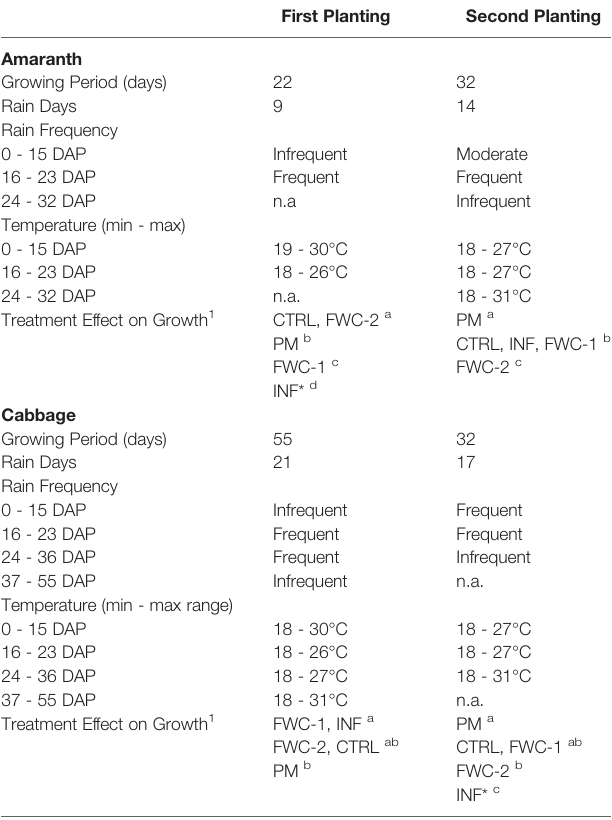
TABLE 9 | Summary of the weather conditions and treatment effects within the two growing periods for amaranth and cabbage plants over the number of days after